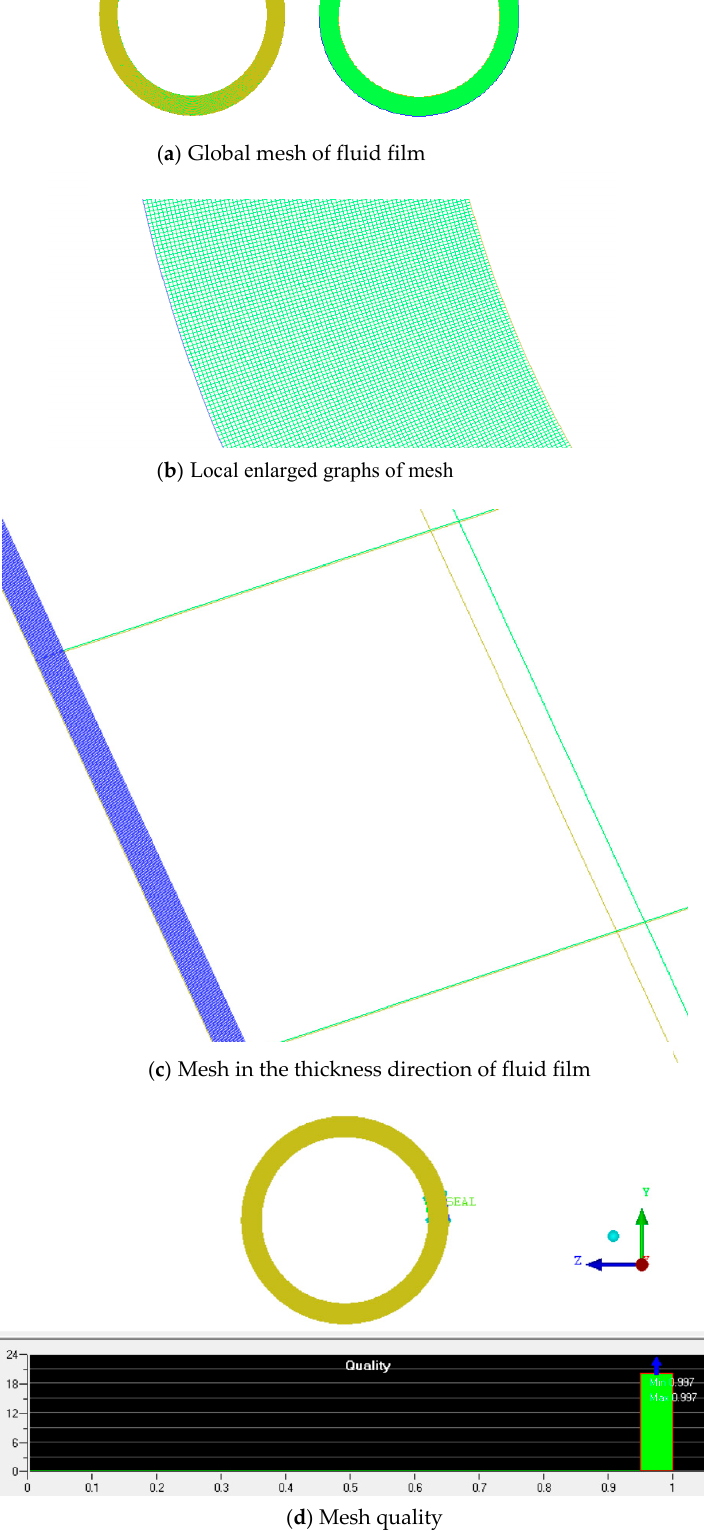
Figure 11. Mesh of fluid film and mesh quality.